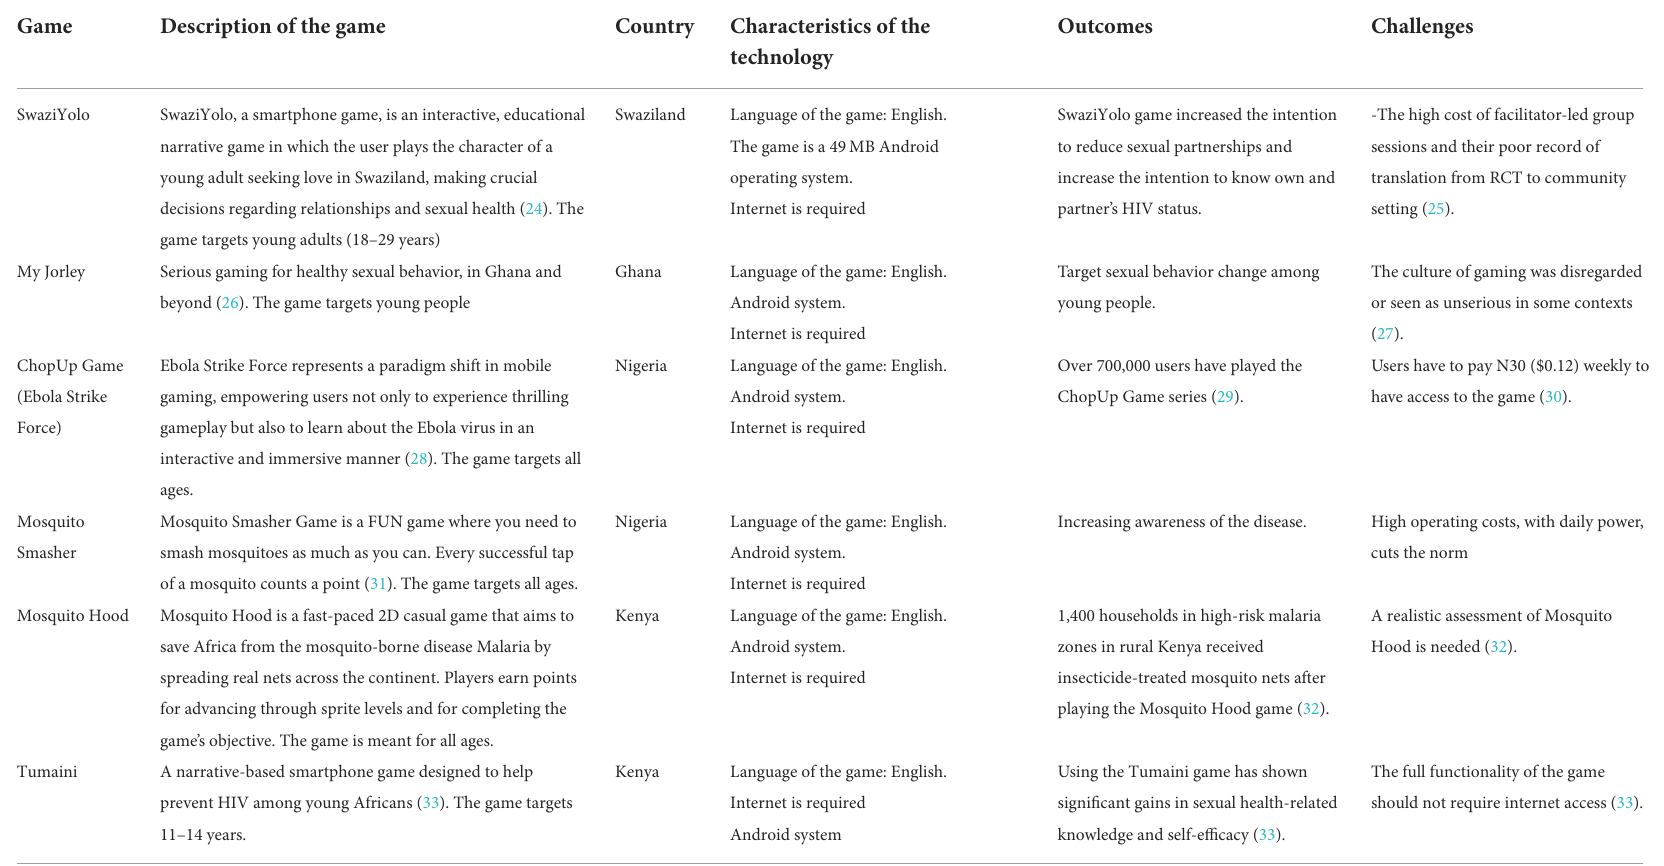
TABLE 1 Mobile serious games interventions to promote health